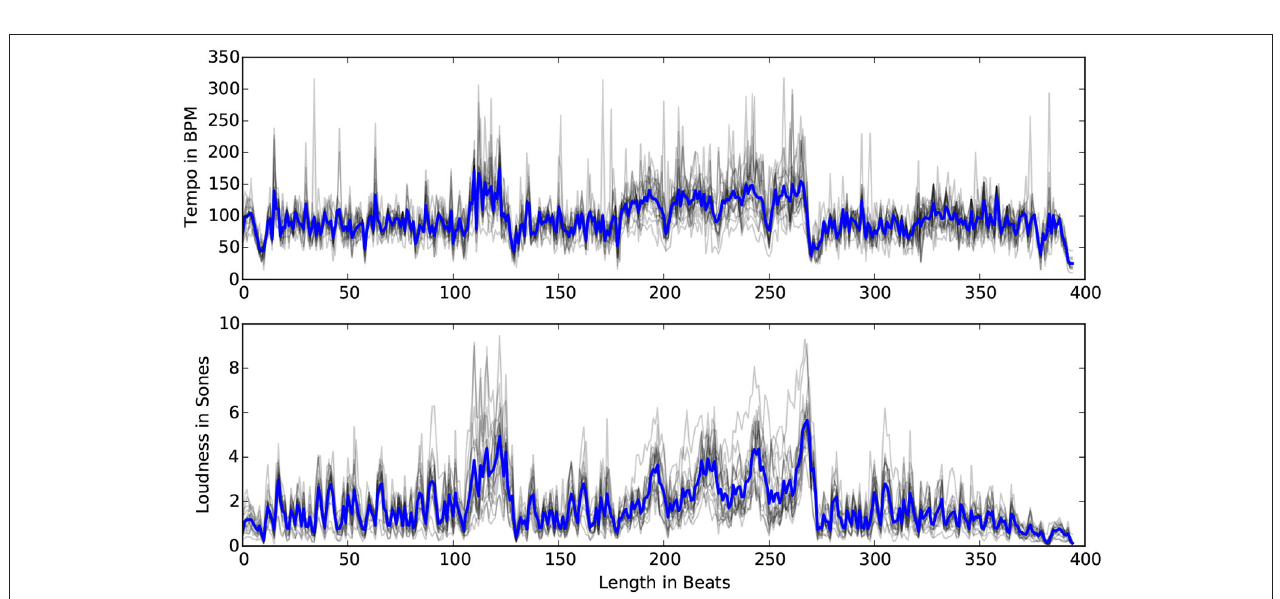
FIGURE 18 | The average tempo and loudness (blue) for 46 performances in the Mazurka Dataset. Gray plots represent the data per pianist.